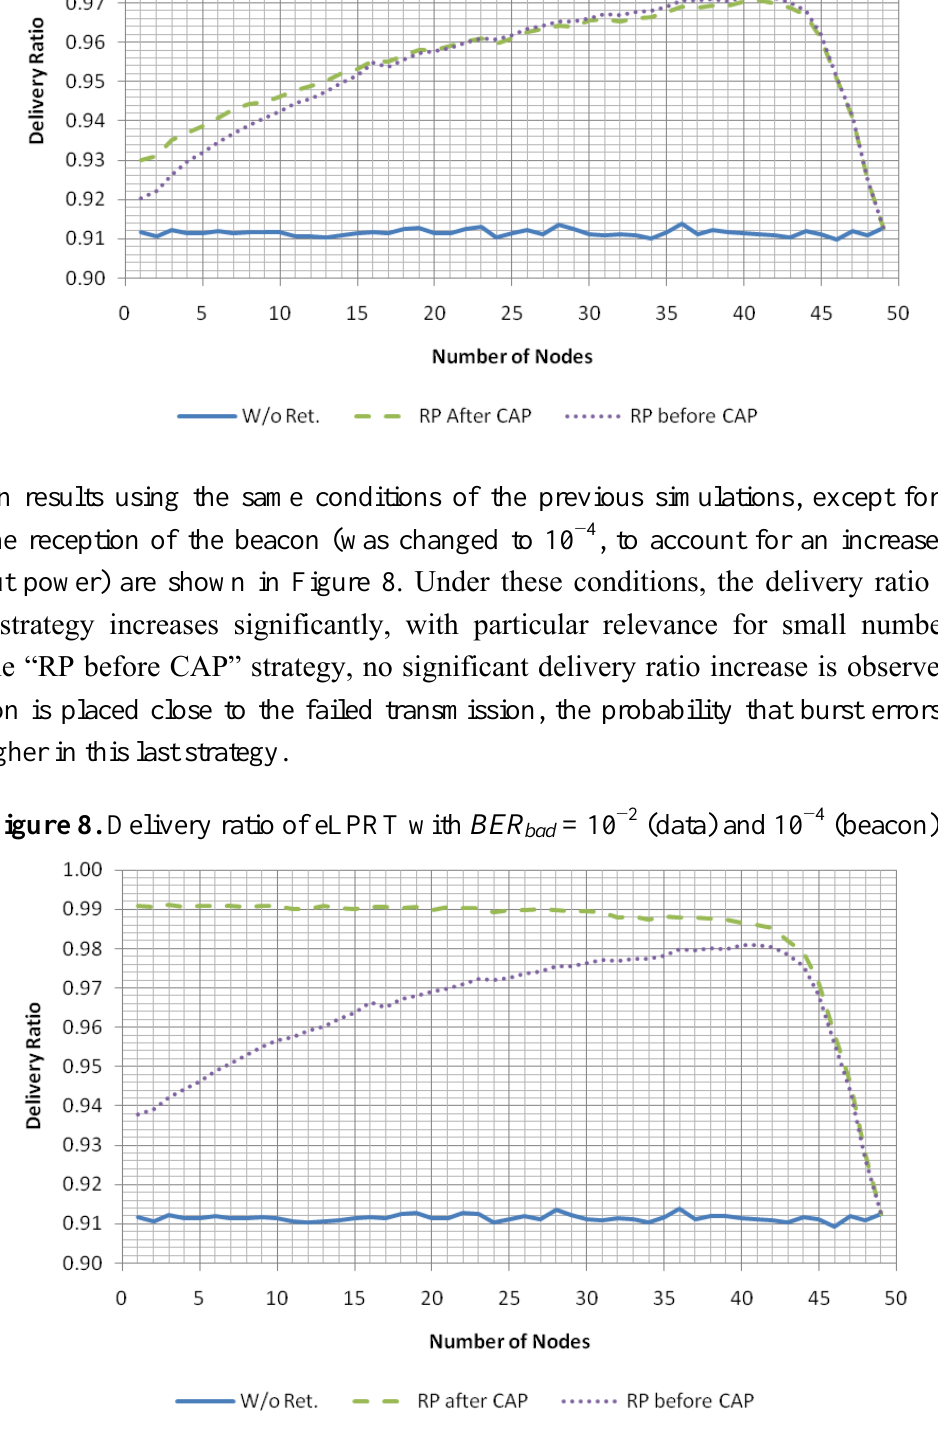
Figure 7. Delivery ratio of eLPRT, with BER